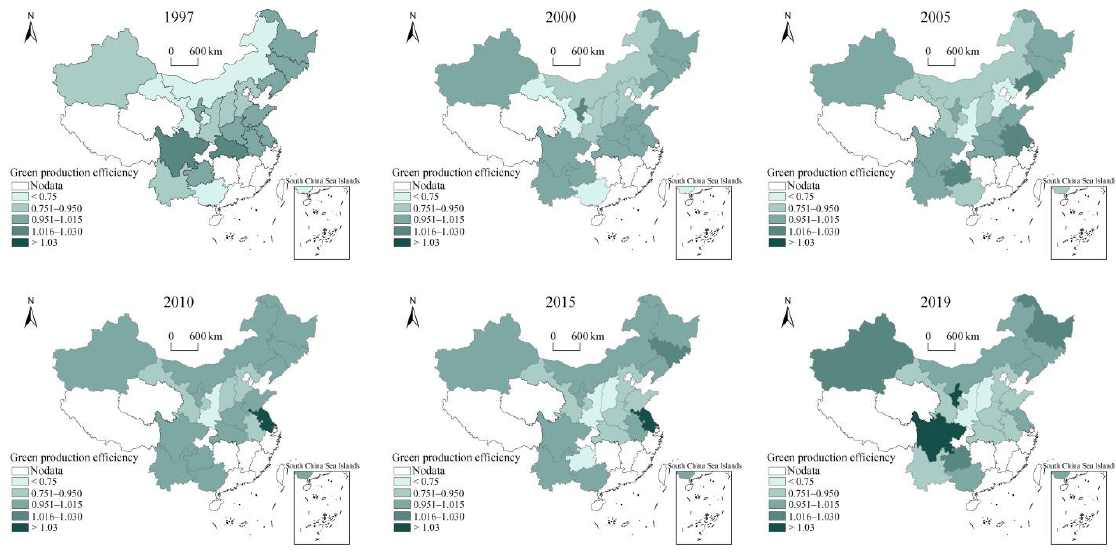
Figure 2. Spatial evolution of MGP from 1997 to 2019.